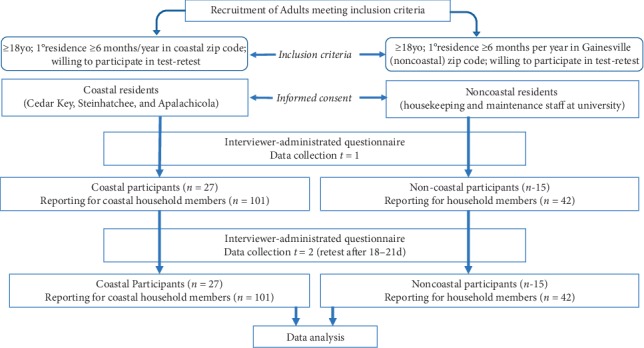
Flow diagram showing validation study design.